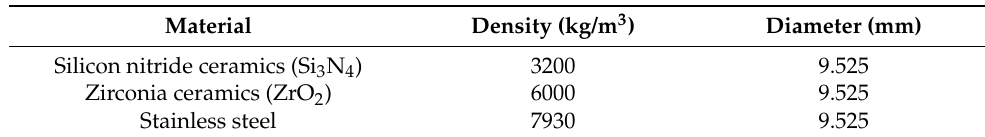
Figure 2. Schematic of the PIV system for investigating the flow field of the wake behind the particle.